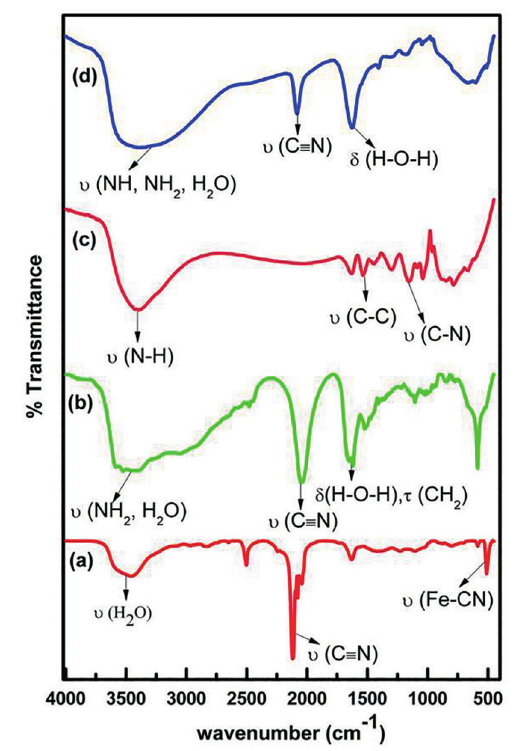
[Fe(CN) ], (b) nanophotoadduct, 3 6